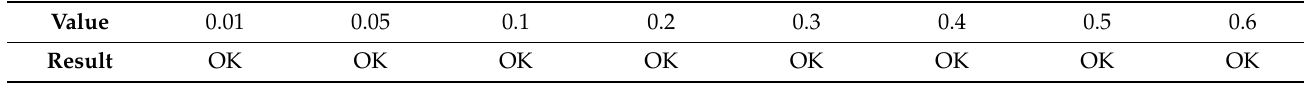
Table 2. The verification of parameter α